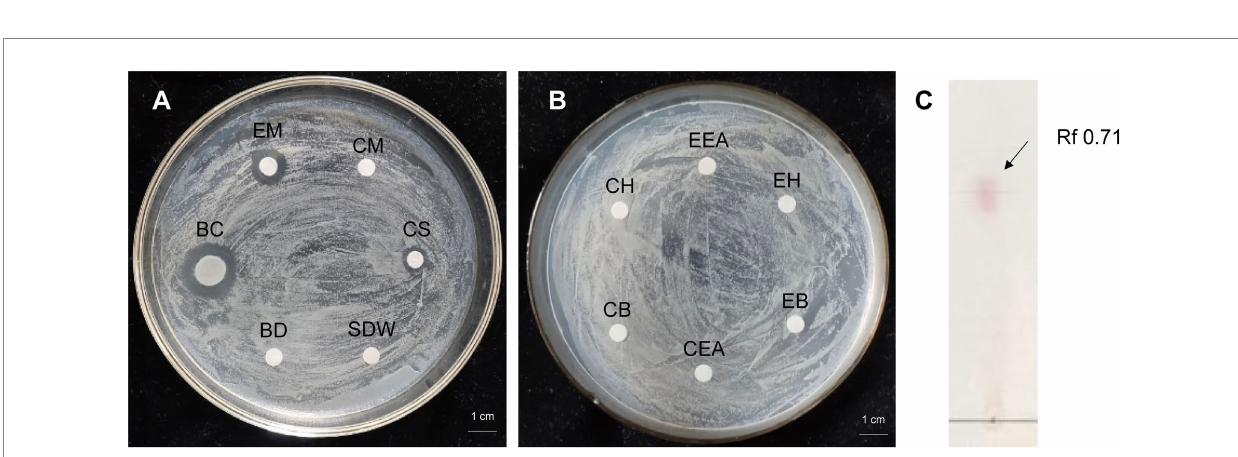
FIGURE 3 The antibacterial activity analysis of organic extracts from P. megaterium strain KD7 against Erwinia amylovora on NA medium (A,B) , and separation of active compounds by thin layer chromatography (TLC) (C) . EM, extracted with methanol; CM, methanol control; BC, bacteria culture broth (1.0 × 10 8 CFU/ml); CS, filtrate from the bacterial cell-free supernatant; BD, filtrate from the bacterial cell disruption; EH, extracted with n-hexane; CH, n-hexane control; EB, extracted with n-butanol; CB, n-butanol control; EEA, extracted with ethyl acetate; CEA, ethyl acetate control; SDW, sterile distilled water